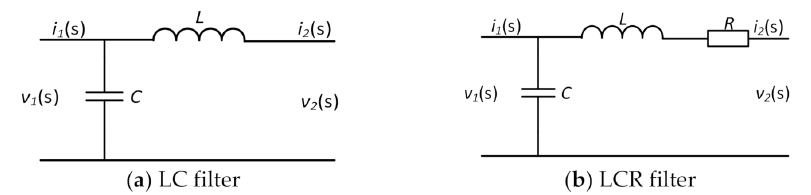
Figure 7. Circuit of LC and LCR filters.